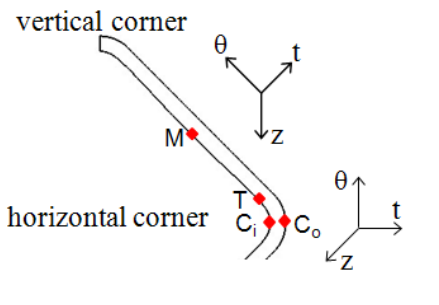
Figure 12. The stress states and mean stresses at the typical feature points during the corner filling